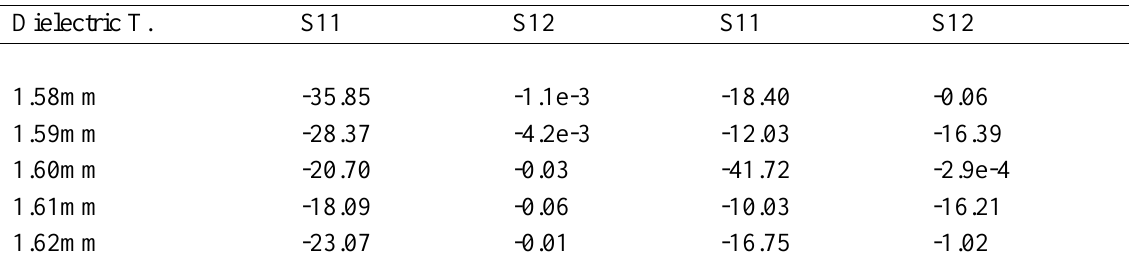
Table 3. Changing dielectric